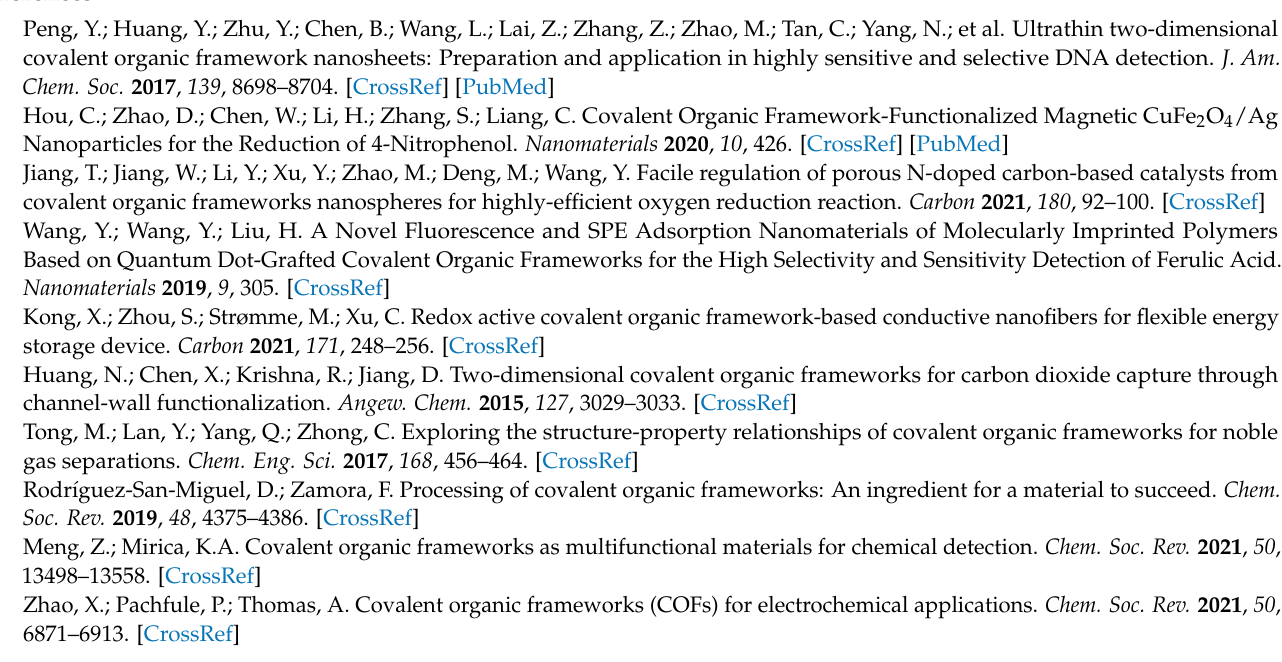
Figure S4: (a) IR spectra of BHU-1-T, and b) IR spectra of BHU-1-T and BHU-2; Figure S5: Pore-size distribution of BHU-1-T; Figure S6: TGA of BHU-1, BHU-1-T, BHU-2, and BHU-2-Oxidate; Figure S7: (a) Pore structure of BHU-1. (b) Pore structure of BHU-1-T. (c) Pore structure of BHU-2. The blue